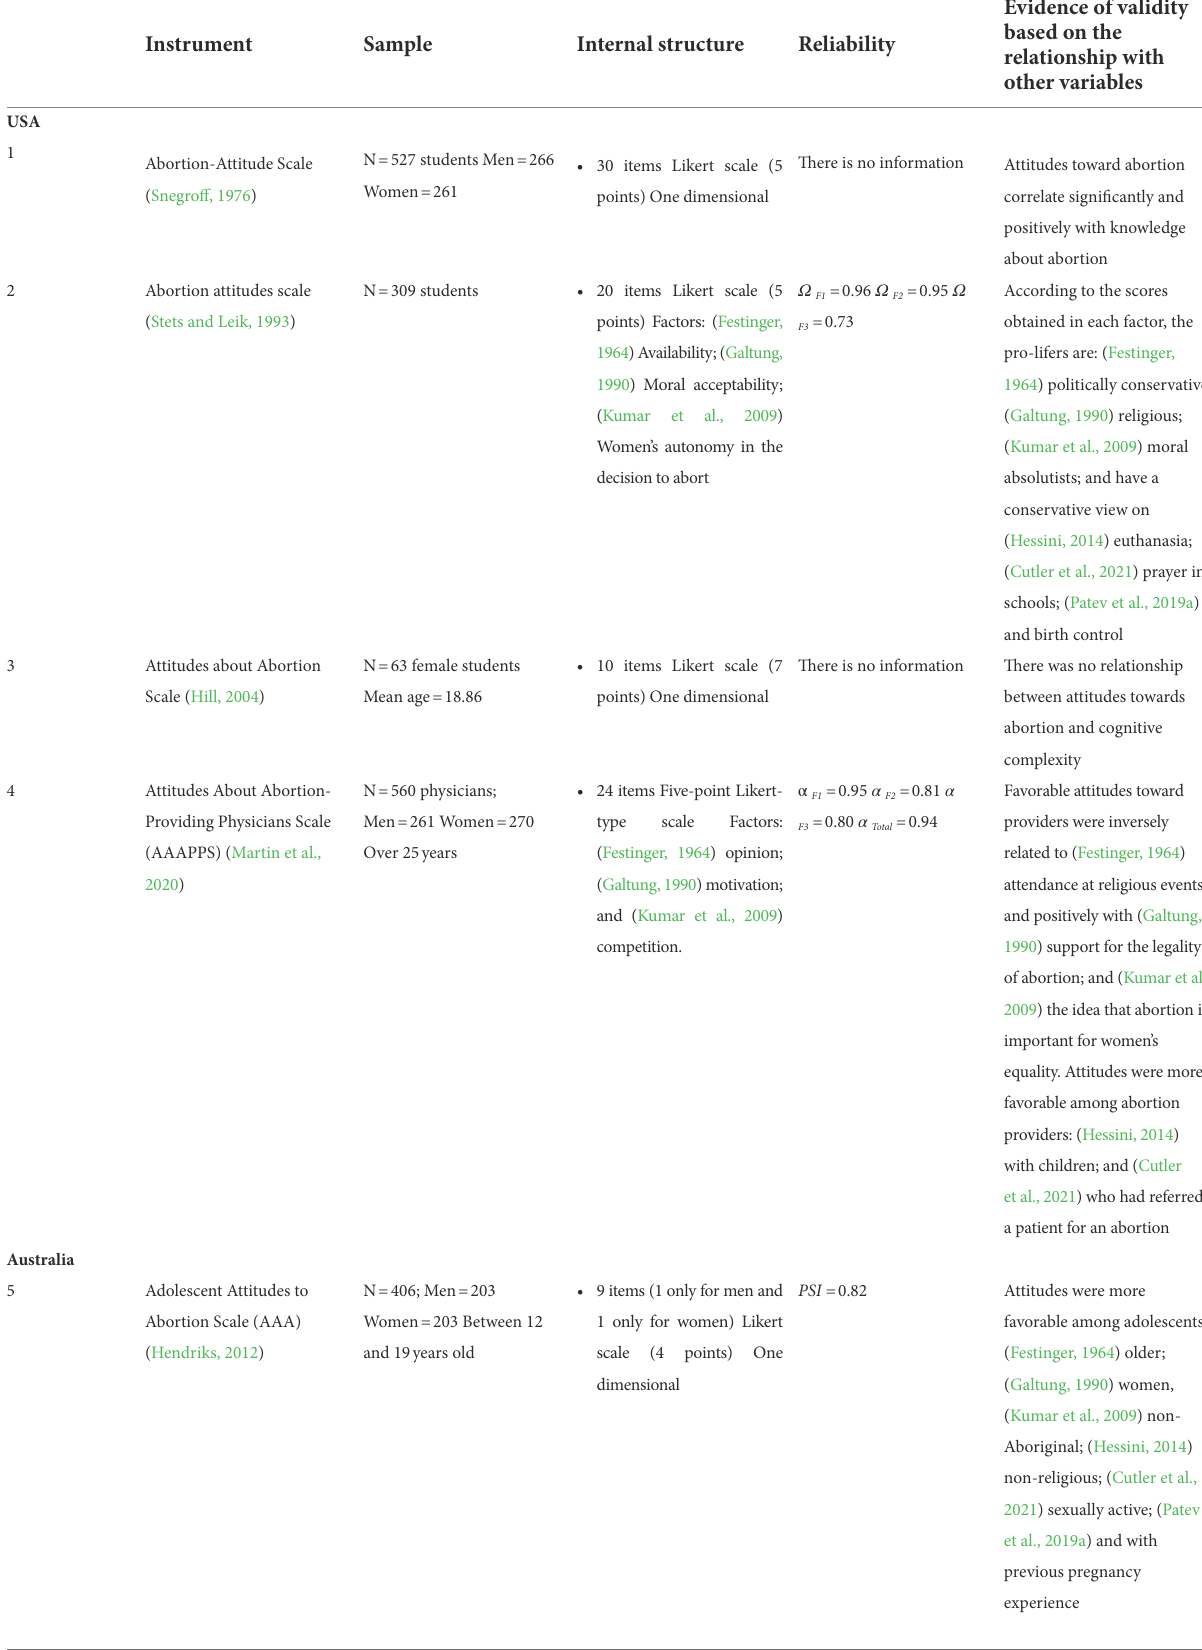
TABLE 1 Scales that have been developed to measure attitudes towards